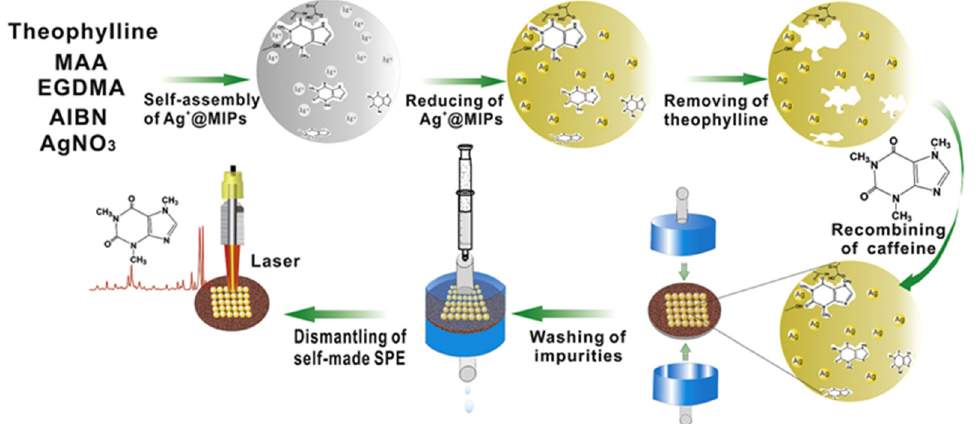
Figure 9. Synthesis of theophylline imprinted AgNPs, and subsequent SPE of caffeine before SERS detection. Reproduced with permission from [75].